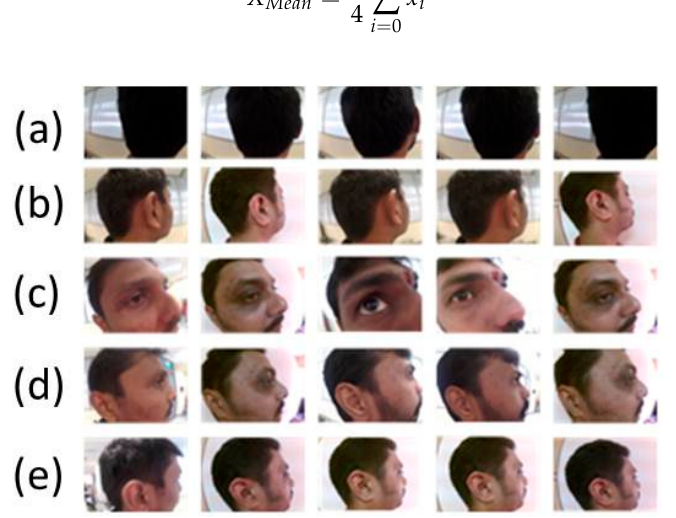
Figure 6. Photographs of the wearer’s head poses, ( a ) Left, ( b ) Left Intermediate, ( c ) Right, ( d ) Right Intermediate, and ( e ) Straight.